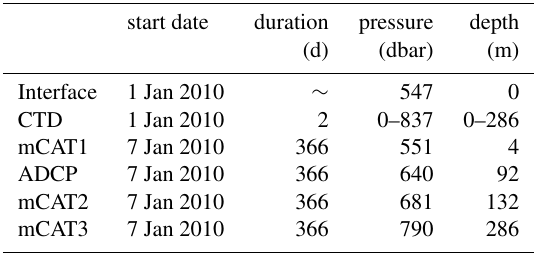
Table 1. Type, duration and depth of measurements from the AM06 borehole. Depth given with respect to the ice–ocean interface on 1 January